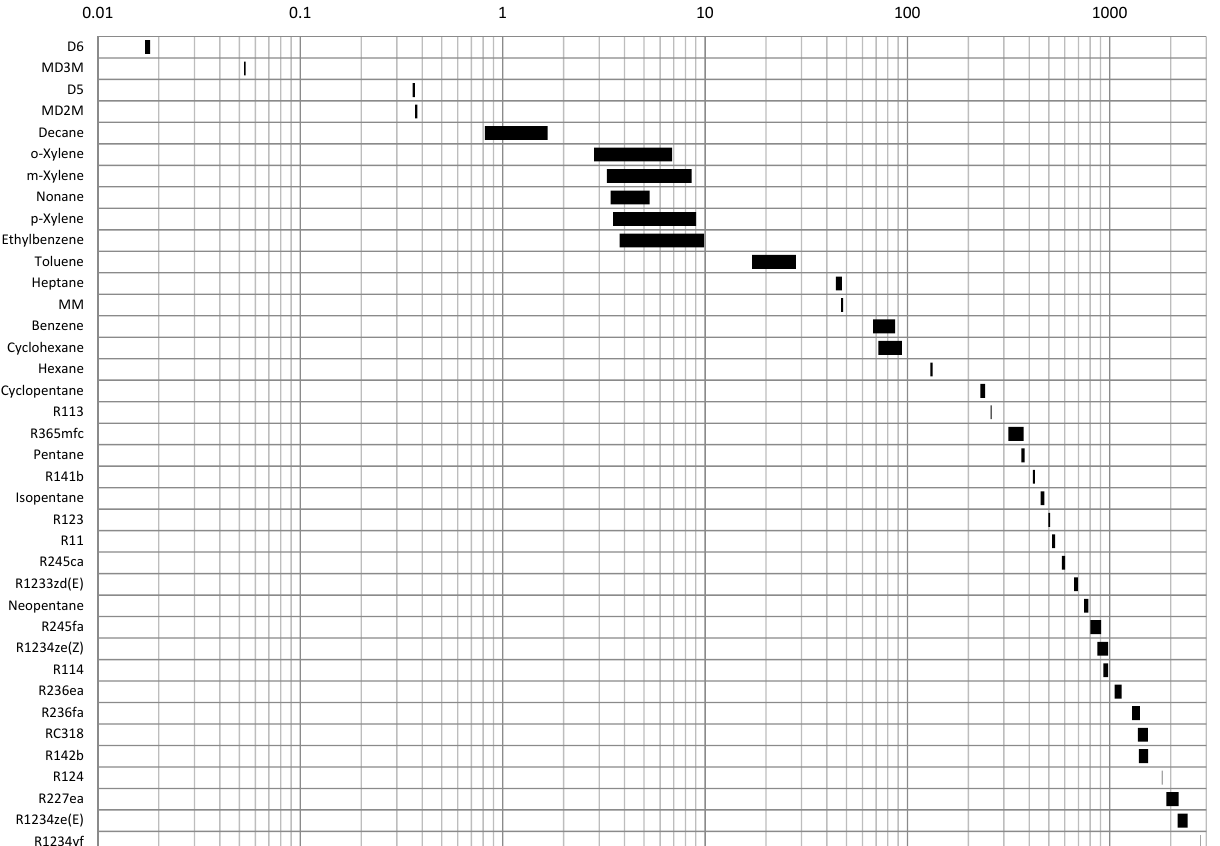
Figure 3. Ranges of calculated condensation pressures (kPa) for each working fluid of the ORC cycle.